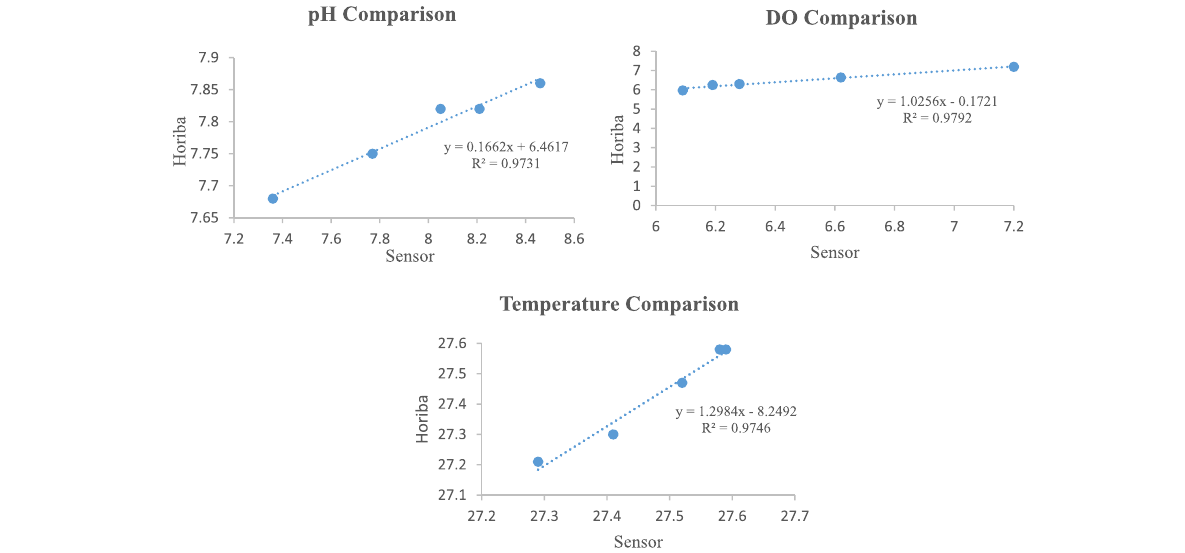
Fig. 7 Linear plots of DO (left), pH (right) and temperature (bottom) values taken using the developed prototyped and Horiba® probe with corresponding R-squared values